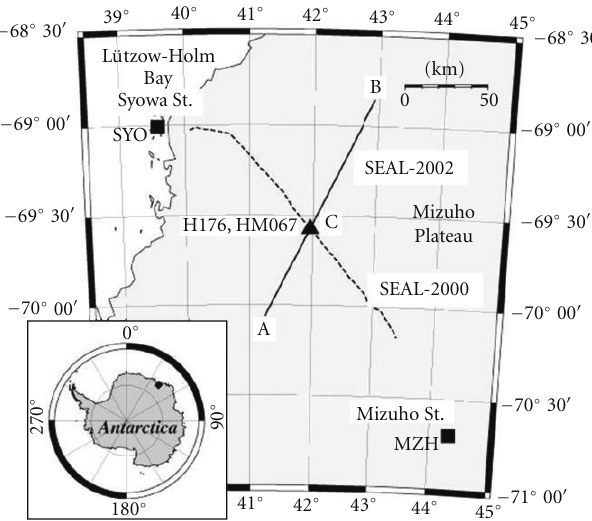
Figure 1: Location map of the seismic profile for SEAL-2002 exploration (solid line; between A and B), together with SEAL-2000 profile (broken line) on the Mizuho Plateau, Eastern Dronning Maud Land, East Antarctica. The data retrieved by SEAL-2002 exploration were used in this study. Names of nearby Japanese stations are as follows: Syowa St. (SYO) at the coast of L¨utzow-Holm Bay and Mizuho St. (MZH) on ice-sheet plateau. The intersection station of the two seismic profiles (C) is indicated by a solid triangle (H176 and HM067 are station codes for SEAL-2000 and SEAL-2002, resp.). The distance measured from the southwestern terminal (A) along the SEAL-2002 profile is utilized as the abscissa in several record sections in this paper (Figures 3, 4, 6, 7, 9, 10, 11, 12, 13, 14, and 15). The extended area in Antarctic continent is indicated by solid rectangle as shown at the lower